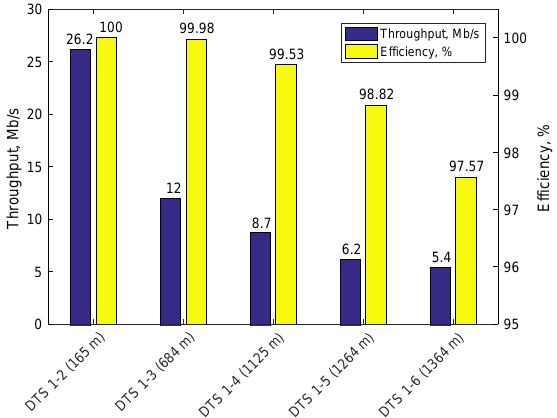
Figure 9. Throughput and Transmission Control Protocol (TCP) efficiency of networks with